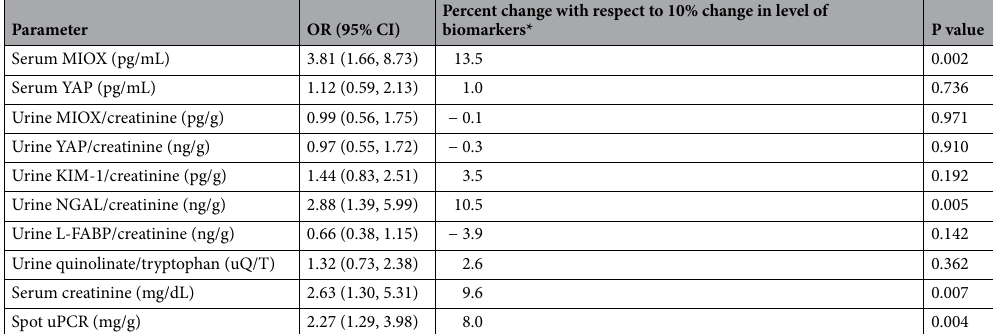
Parameter OR (95%